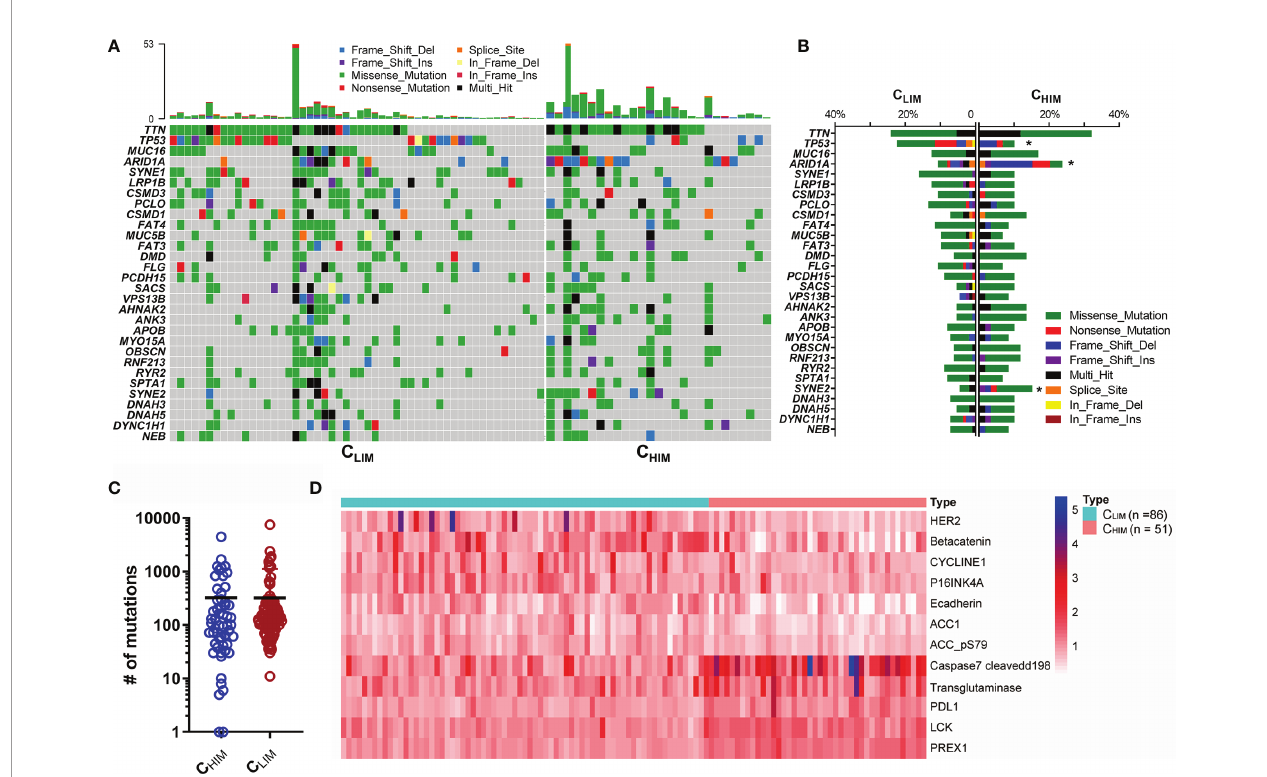
FIGURE 4 | Genomic and proteomic features of different immune subtypes. (A) Oncoprint of gene mutations in C HIM vs. C LIM subtypes in the TCGA cohort. The top 30 mutated genes are shown. (B) Frequencies of mutations of the top 30 mutated genes in C HIM vs. C LIM patients. (C) Tumor mutation burden of the C HIM and C LIM patients in the TCGA cohort. (D) Differentially expressed proteins between C HIM and C LIM subgroups. * P <